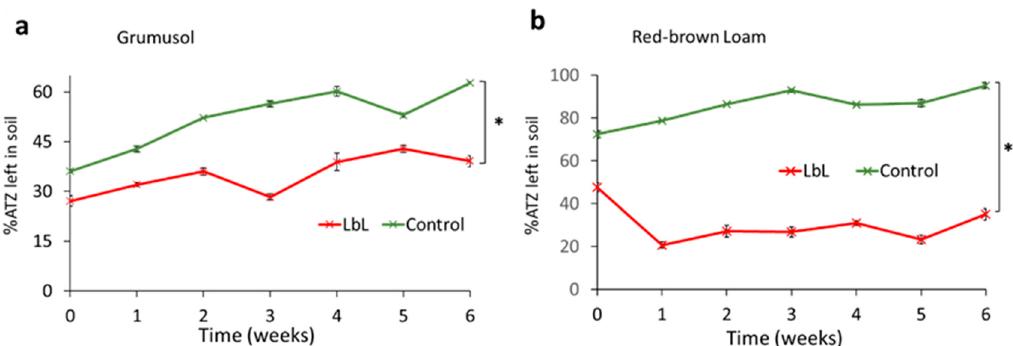
Figure 6. Removal of ATZ from contaminated soil over the course of 6 weeks: ( a ) Grumusol and ( b ) red-brown loam. The control measures ATZ concentrations in the soil without the addition of ATZ-degrading bacteria. * Indicates significant difference between the groups ( p < 0.05).